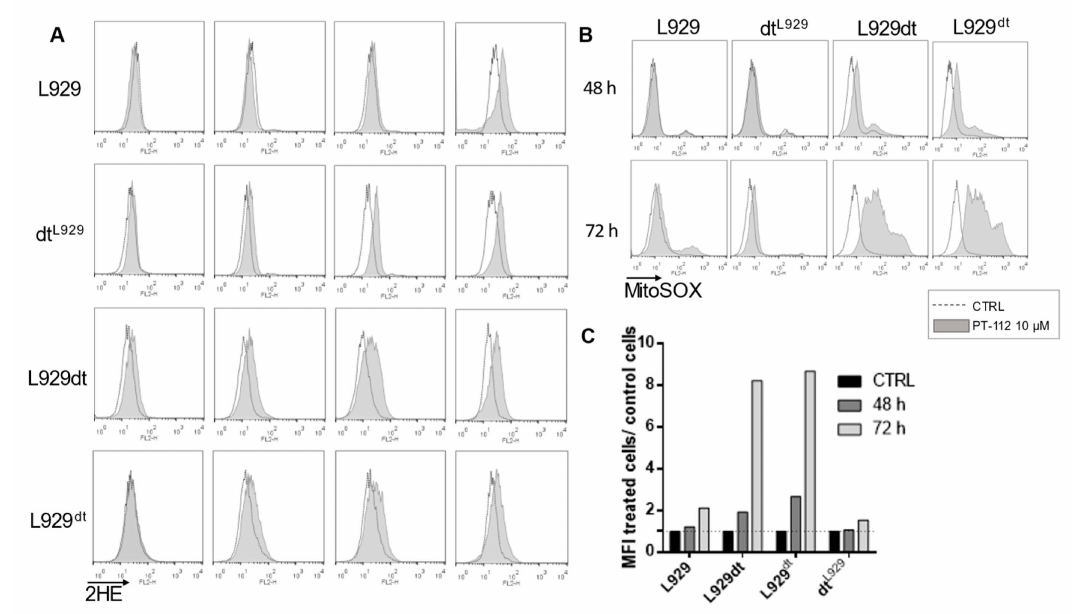
Figure 6. Analysis of total and specific mitochondrial ROS production upon treatment with PT-112 at different incubation times. ( A ) A total of 3 × 10 4 cells were incubated with 10 µ M of PT-112 for 24, 36, 48 and 72 h at 37 ◦ C. Total ROS production was determined by staining with 2HE and flow cytometry. ( B ) Specific mitochondrial ROS production after incubation with 10 µ M of PT-112. Cells were stained with a mitochondrial superoxide indicator MitoSOX™ for 15 min at 37 ◦ C, in darkness. The fluorescence intensity values of treated cells compared to control cells (CTRL) were determined by flow cytometry. As shown in the legend, dotted histograms correspond to the fluorescence of untreated cells, and grey-colored histograms correspond to the fluorescence values of treated cells. ( C ) Graphical representation of data obtained in Figure 6B. Data are shown as MFI of treated cells compared to untreated